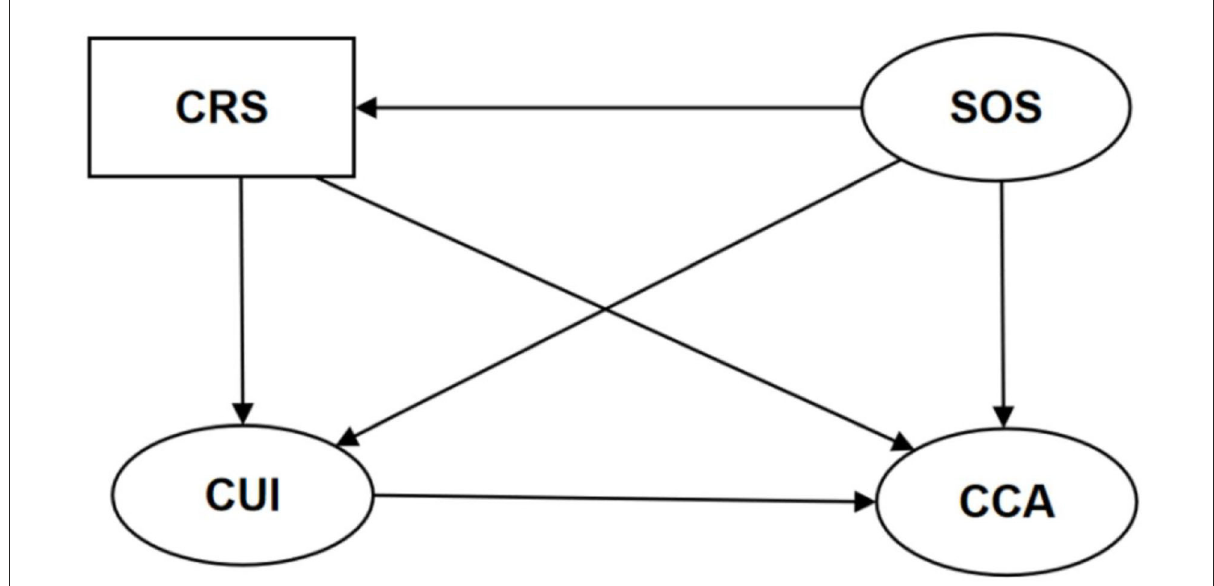
FIGURE1 The hypothetical model. CRS, caregivers’ resilience state; SOS, the severity of stroke; CUI, caregivers’ uncertainty about the illness; CCA, caregivers’ caregiving